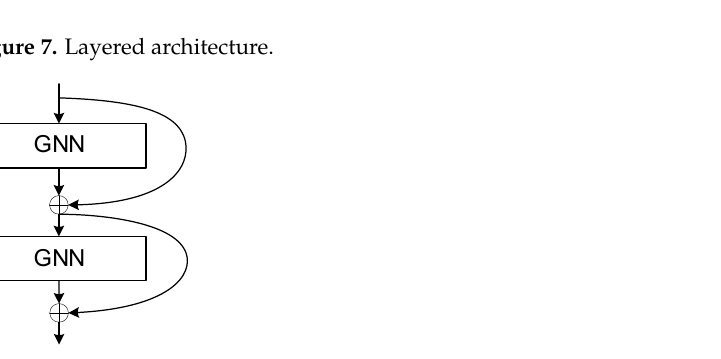
Figure 8. The residual structure for